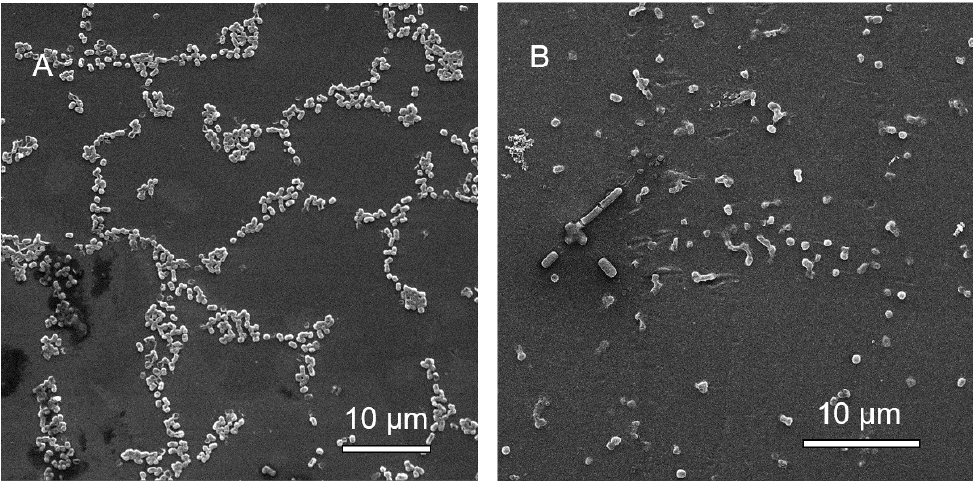
Figure 7. Scanning electron micrographs of C. portucalensis biofilm inoculation pegs at ( A ) the lowest (7.8 μ g/mL), and ( B ) the highest (1000 μ g/mL) concentrations of neomycin. The images are magnified 3600× and 4880×, respectively.